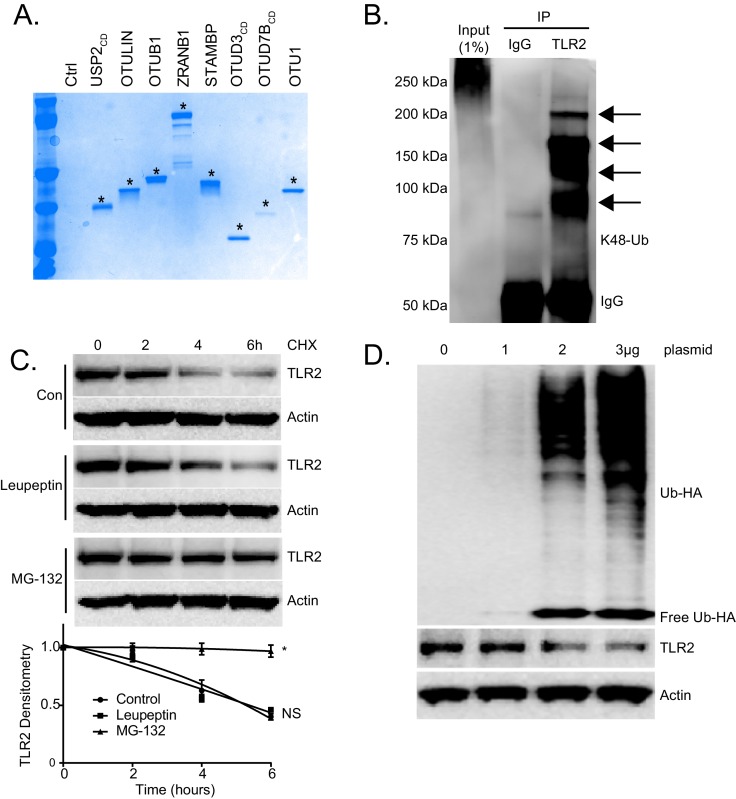
TLR2 is regulated by Ubiquitination.(A) Coomassie blue staining of UBICrest supernatant following DuB assay. Stars represent indicated Dub signal (Figure 1B). (B) TLR2 immunoprecipitation from MLE cells prior to immunoblotting for K48-specific ubiquitin linkages. (C) TLR2 protein half-life study with MG132 or Leupeptin. Below the panel levels of each protein on immunoblots were quantified densitometrically and shown graphically. Data represent mean values ± SEM (n = 3); *p<0.05, significant compared to Control, Student’s t-test. (D) Immunoblots showing levels of TLR2 proteins and HA-Ubiquitin after ectopic Ubiquitin plasmid expression.DOI:
http://dx.doi.org/10.7554/eLife.18496.00410.7554/eLife.18496.005Figure 1—figure supplement 1—source data 1.This file contains raw source data used to create graphs in Figure 1—figure supplement 1.